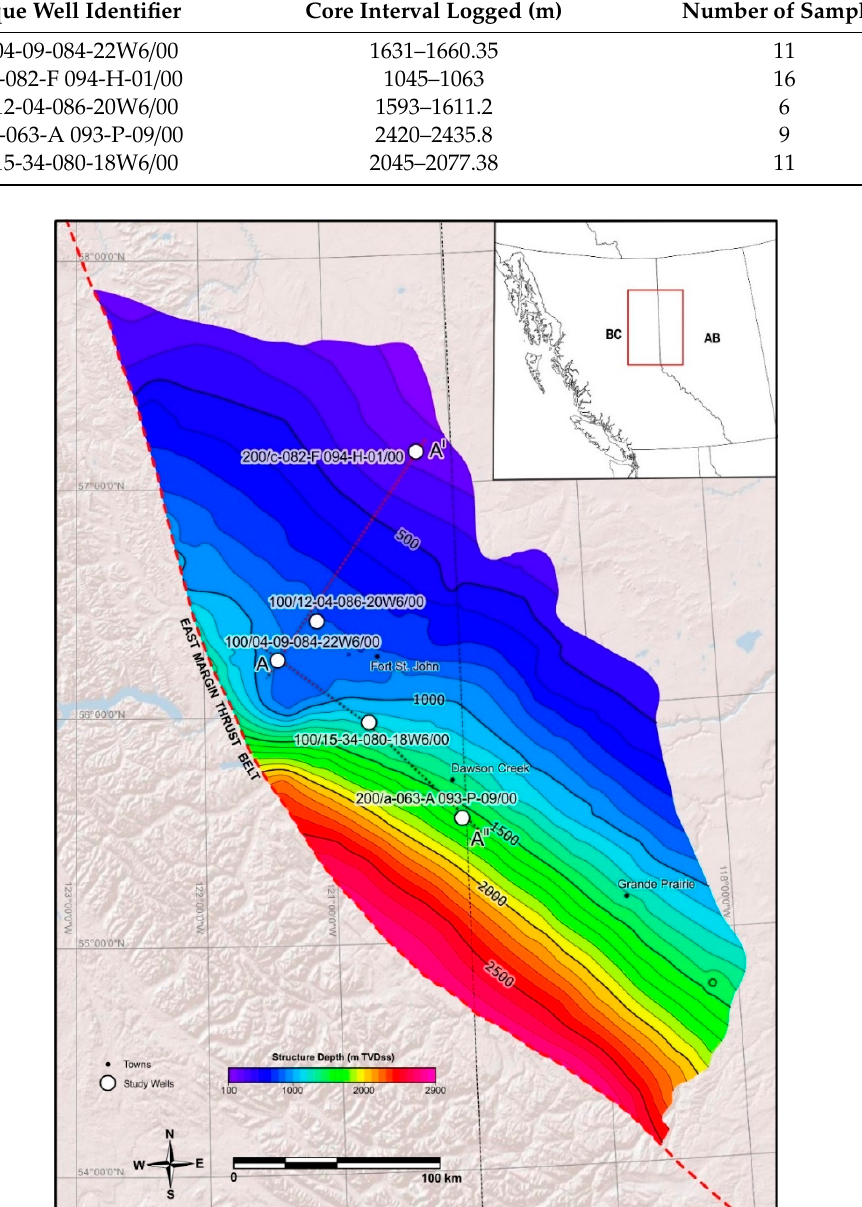
Figure 1. Location of wellbores used in this study and cross-sections on a map of the Doig top structure [25] with elevations expressed in vertical meters below mean sea level permanent datum, and shaded relief topographic backdrop map.